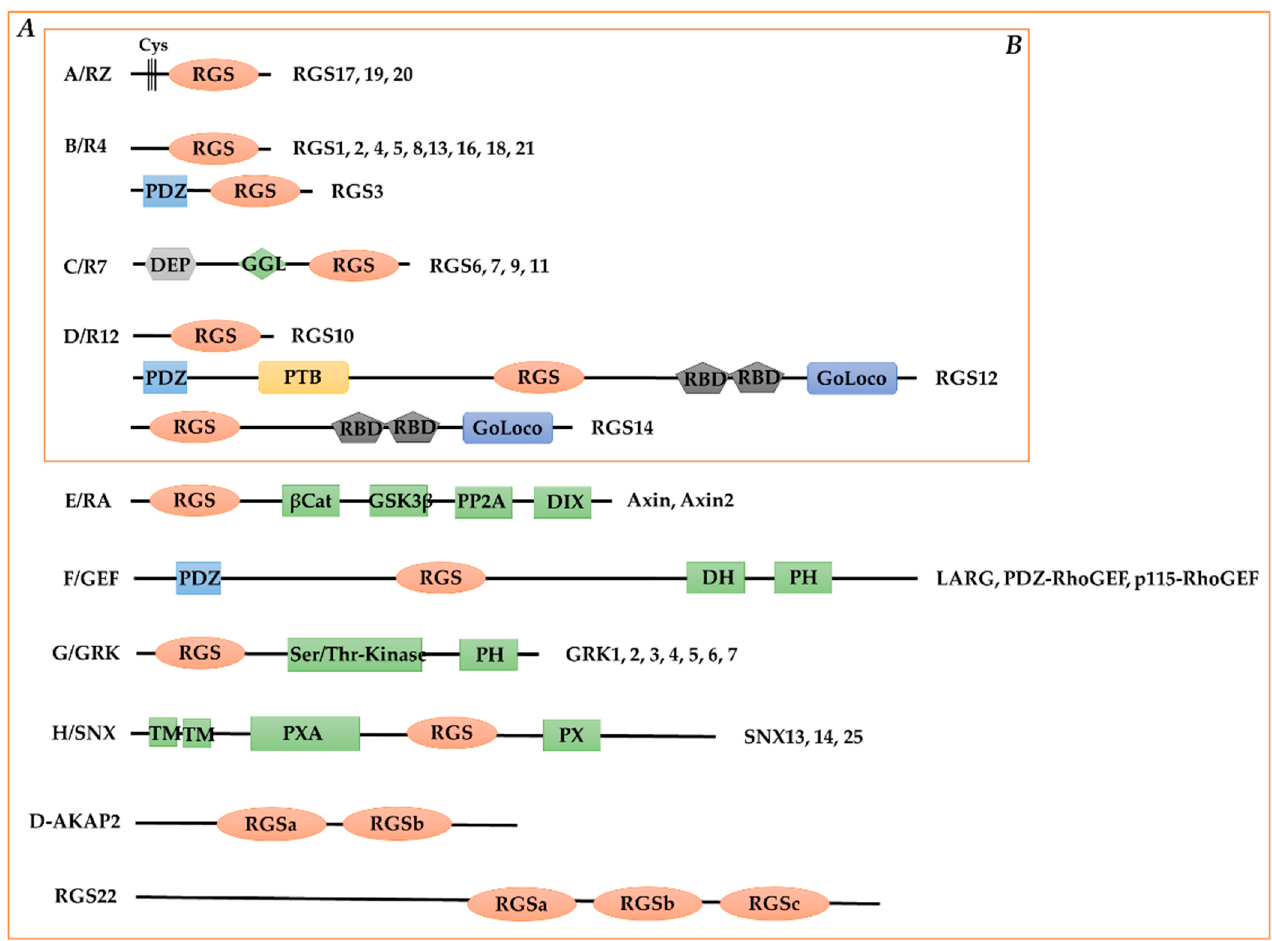
Figure 2. Members and their multidomain structures of the mammalian RGS protein